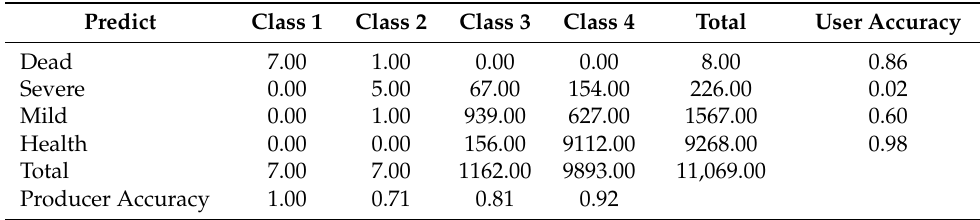
Table 7. Confusion matrix of tree health status based on unsupervised classification for the study